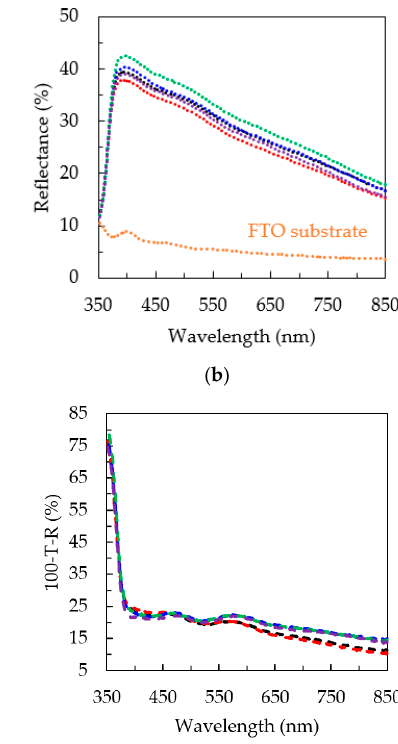
Figure 3. The ( a ) transmittance (T), ( b ) reflectance (R), ( c ) absorbance, and ( d ) haze spectra for the TiO 2 films prepared by injecting different DMF doses from 0 to 10 wt%, where the inserted haze image is in the range from 500 to 700 nm.